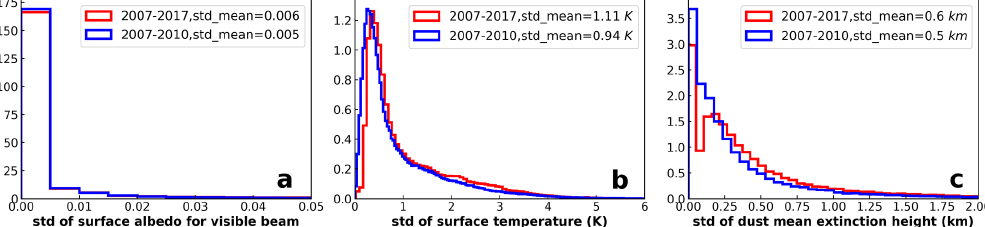
Figure 9. Probability density function (PDF) of 4-year and 10-year interannual standard deviation (std) in monthly mean (a) surface albedo, (b) surface temperature, and (c) dust mean extinction height. The PSD analyses include interannual std in 12months and all 5 ◦ (longi- tude) × 2 ◦ (latitude) grid cells over the world and their mean values are indicated as std_mean on each